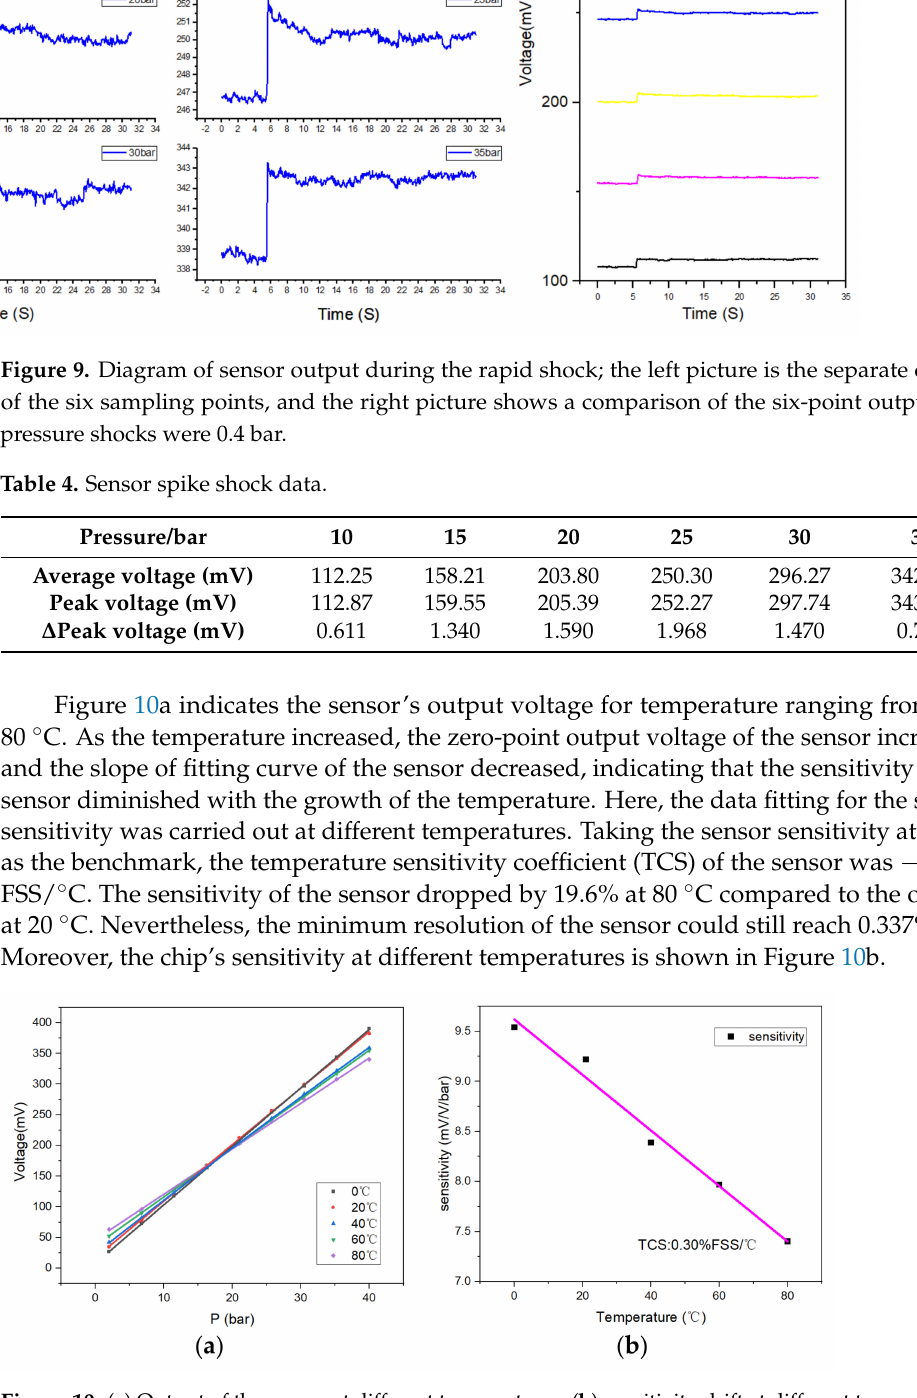
Figure 10. ( a ) Output of the sensor at different temperatures; ( b ) sensitivity drift at different